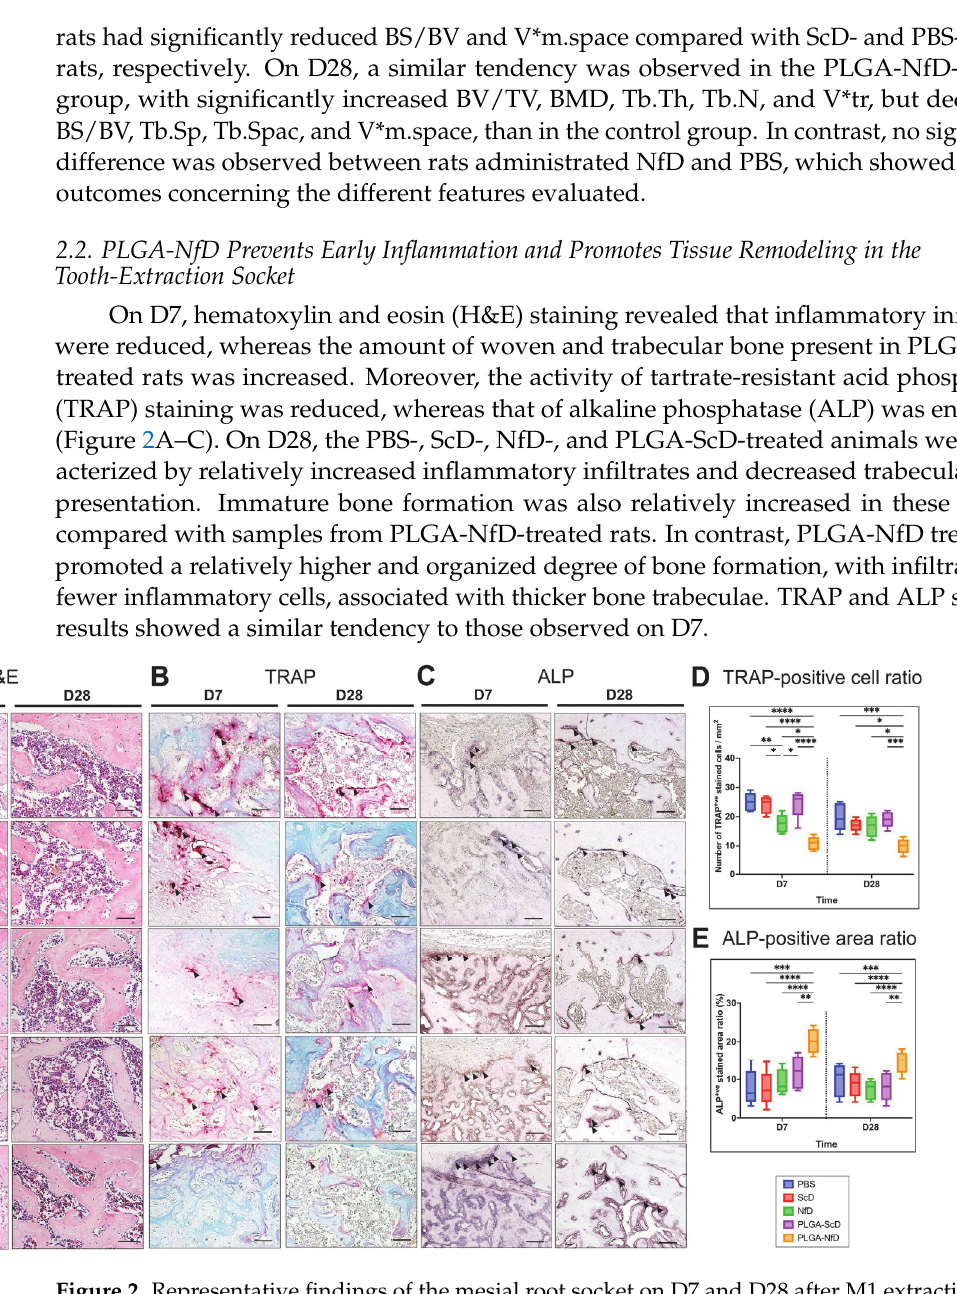
Figure 2. Representative findings of the mesial root socket on D7 and D28 after M1 extraction in all groups. ( A ) Hematoxylin and eosin (H&E) staining; ( B ) tartrate-resistant acid phosphatase (TRAP) staining; ( C ) alkaline phosphatase (ALP) staining. Magnification, 200 × . Black arrow indicates positive region. Scale bar = 100 µ m. ( D , E ) Relative semiquantitative analysis of TRAP and ALP staining of the M1 extraction socket. Abbreviations: D7, post-extraction day 7; D28, post-extraction day 28; NfD, naked NF- κ B decoy; NF- κ B, nuclear factor-kappa B; ODN, oligodeoxynucleotide; PBS, phosphate- buffered saline; PLGA, poly(lactic-co-glycolic acid); PLGA-NfD, NF- κ B decoy ODN-loaded PLGA nanosphere; PLGA-ScD, scrambled decoy ODN-loaded PLGA nanosphere; ScD, naked scrambled decoy. Values are presented as mean ± standard deviation ( n = 5). * p < 0.05, ** p < 0.01, *** p <